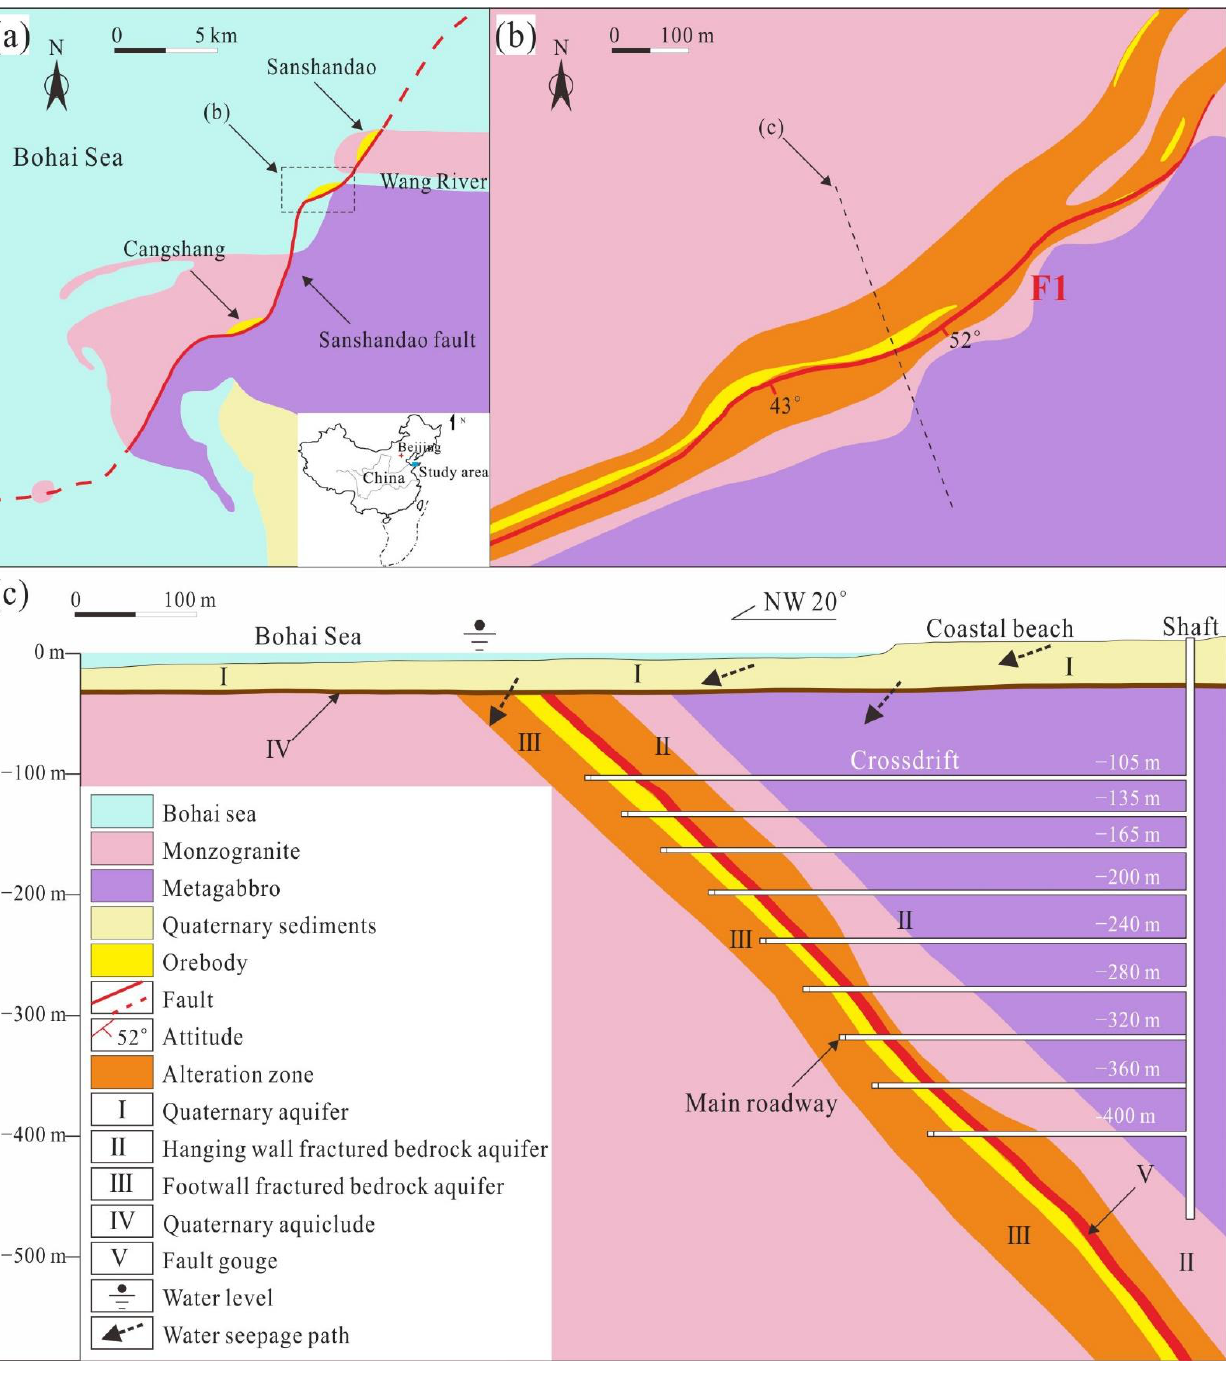
Figure 1. Engineering geological map of Sanshandao Mine. ( a ) Simplified geologic map showing the Sanshandao fault and other features; ( b ) close-up geologic map of the Xinli gold deposit area showing the fault and cross-section location; ( c ) cross-section showing the fault, geology, and hydrogeologic features, as well as the underground workings of the Xinli gold deposit. Horizontal tectonic stress plays a significant role in this area. The measured maxi- mum principal stress value in the mining area can be as high as 35 MPa. The in-situ stress field in the study area is evenly distributed, without obvious mutation points. The meas- ured values of the ground stress at different depths are presented in Table 1.